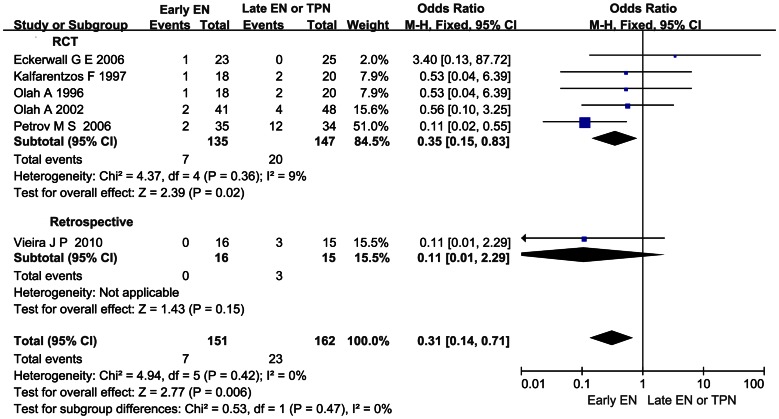
Forest plot showing the effect of early EN on the mortality in AP.Fixed-effect model was applied and sensitivity analysis subtotaling the plots by RCTs vs. retrospective studies was conducted.